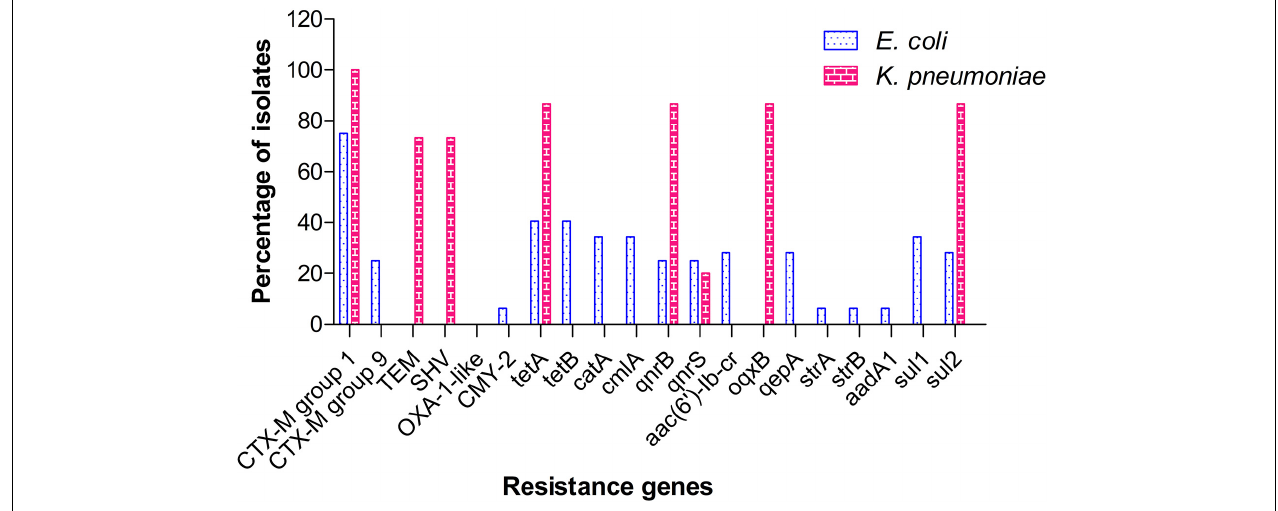
FIGURE 3 | Distribution pattern of resistance genes among isolates of ESBL-producing E. coli and K.